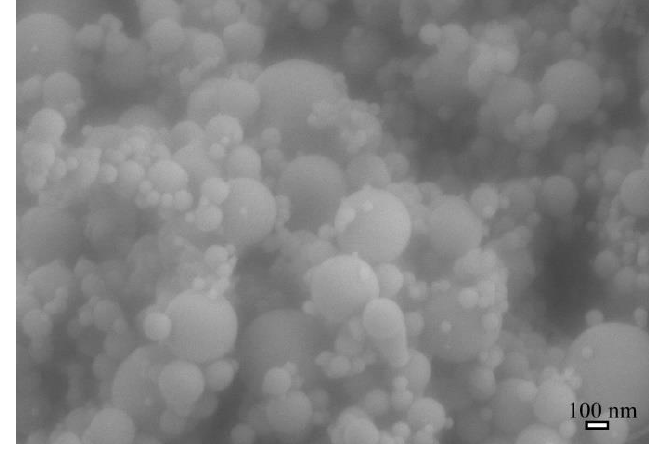
Figure 1. Morphology of silica particles. Table 1. Chemical composition and physical properties of the cement.